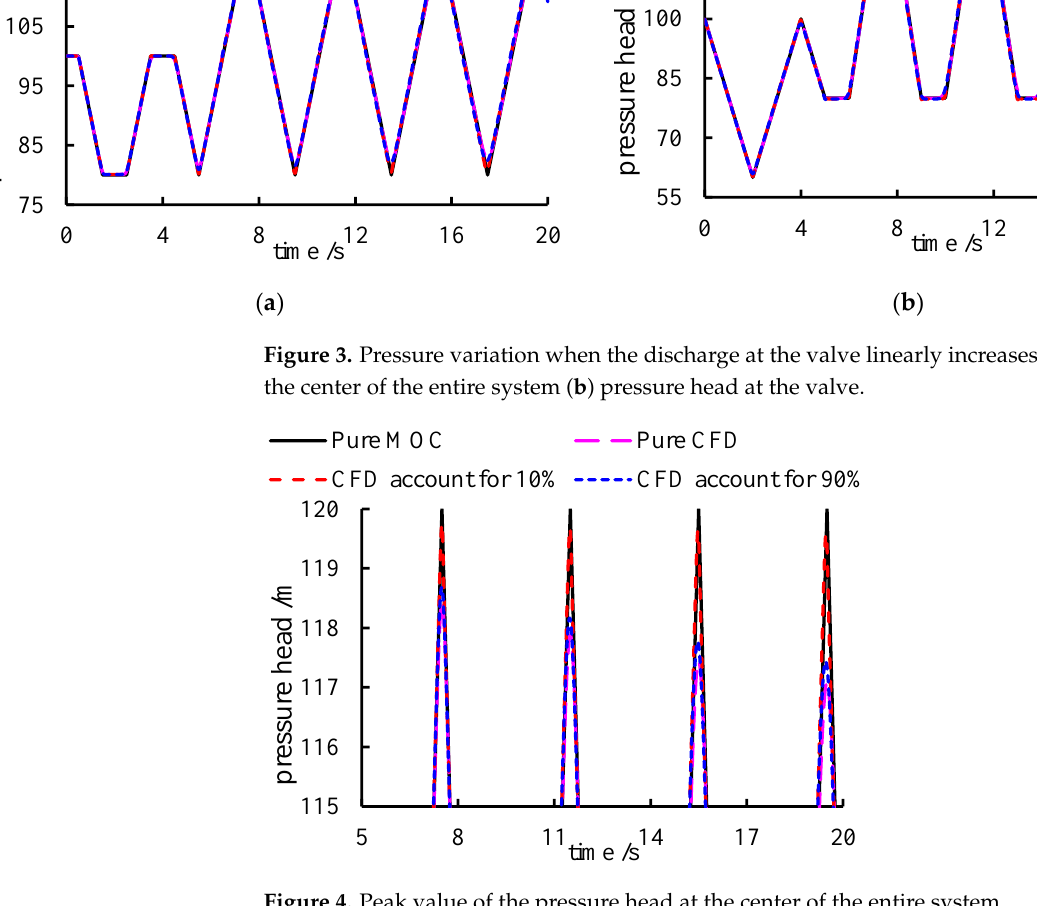
Figure 4. Peak value of the pressure head at the center of the entire system.